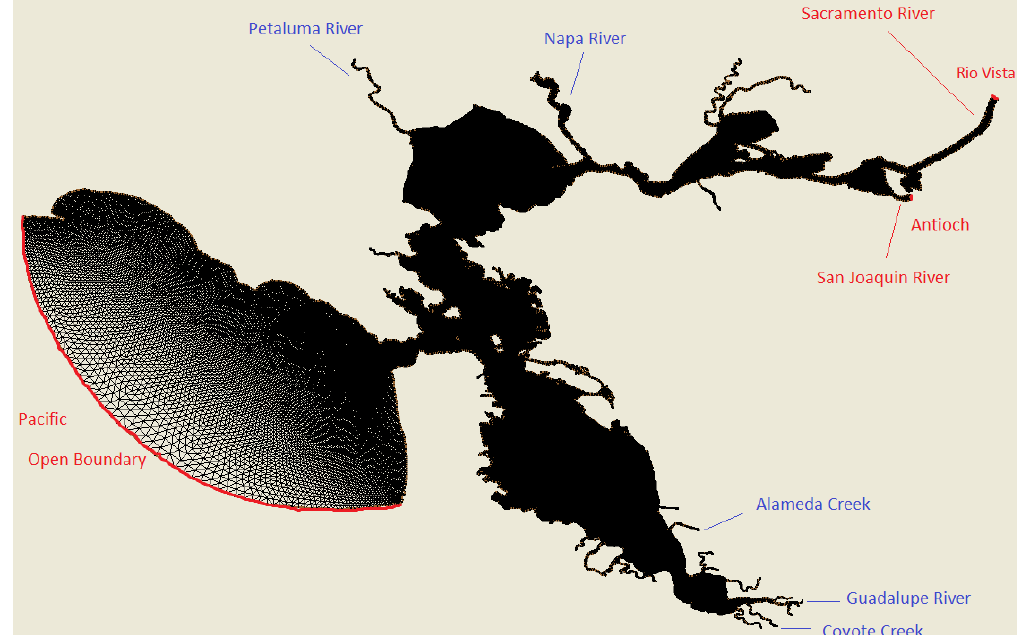
Figure 2. The SFBOFS grid structure and the open boundaries. Measured river flow data from USGS are used as river forcings for the five small rivers in blue. Measured river flow or river stage data at Rio Vista and Antioch may be used as river forcings, respectively, for Sacramento River and San Joaquin River. Technically, if river stage data are employed, the grid points across these two major rivers are treated the same way as those on the Pacific Open